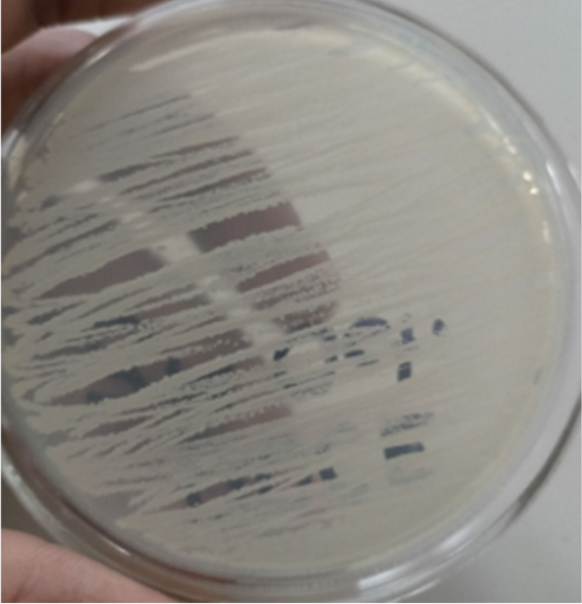
Figure 1. Growth of Pseudomonas Bacteria.